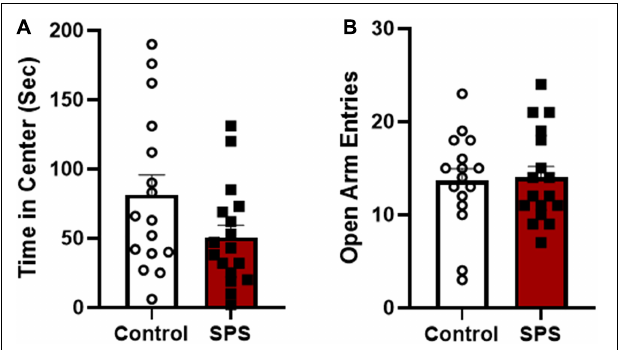
FIGURE 3 | Anxiety-like behaviors were measured 8–9 days following SPS ( N = 17) or control handling ( N = 16). (A) Time spent (sec) in the center of the open field test is shown for control and SPS-exposed rats (control vs. SPS, P = 0.0718). (B) Number of open arm entries on the elevated plus maze testing is shown for SPS and non-stressed control rats (control vs. SPS, P >